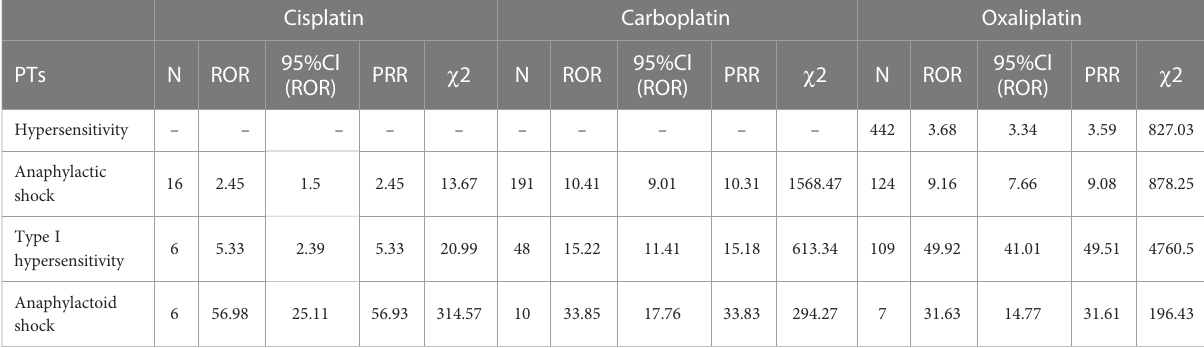
TABLE 8 Immune system disorder-related adverse events of Cisplatin, Carboplatin and Oxaliplatin. Cisplatin